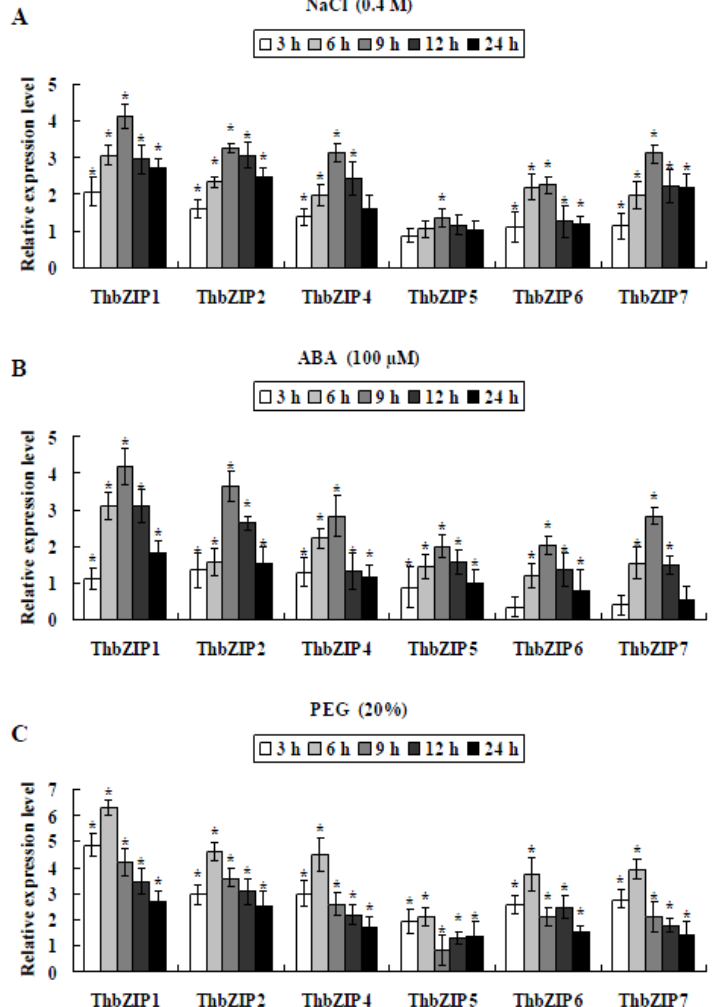
Figure 3. The expression patterns of ThbZIPs in response to abiotic stresses and ABA (abscisic acid). ( A , B , C ) The expression patterns of ThbZIPs in response to salt, ABA, and osmotic stress treatments. The error bars were obtained from multiple replicates of the real-time PCR assays. Data are shown as the means ± SD from three independent experiments. * Significant ( t -test, p < 0.05) differences compared with the expression at 0 h; and ( D ) Hierarchical cluster analysis of the expression of ThbZIPs in response to abiotic stress. All the ratios were log2-transformed for cluster analysis. Log ratios of 0 (ratios of 1) are colored black, and induction or repression ratios are colored red or green with increasing intensity,